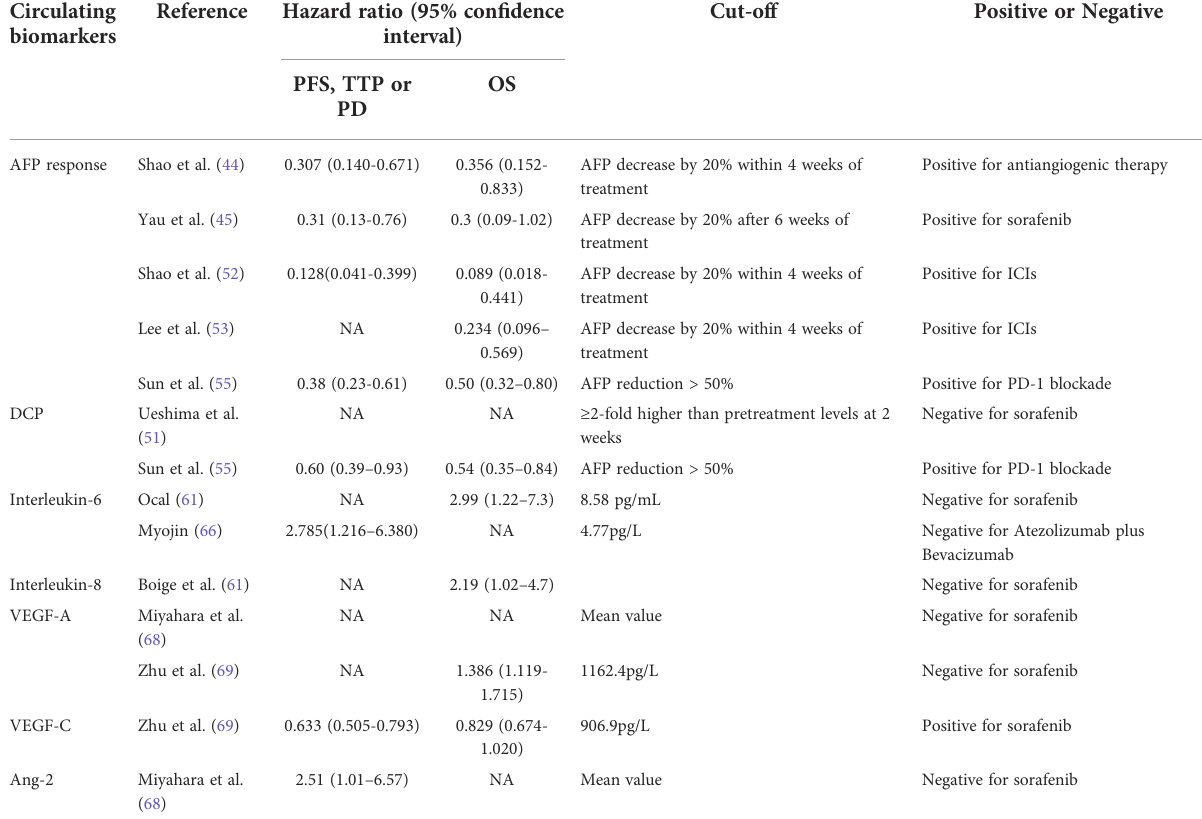
TABLE 2 Circulating predictive biomarkers for the systemic treatment of hepatocellular carcinoma. Circulating